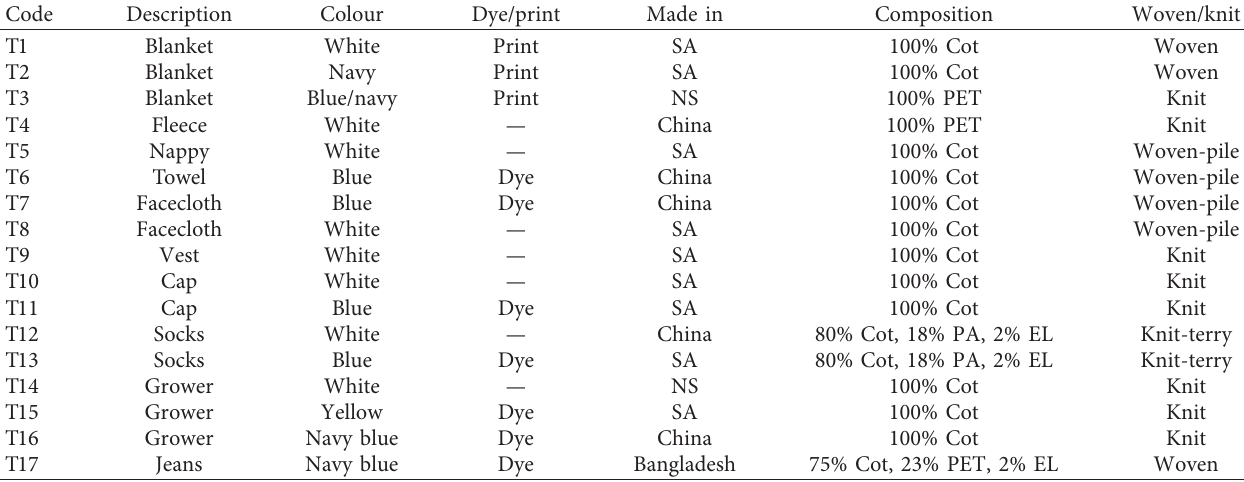
Table 1: Sample code, description, colour, composition, and apparel type from a high-end market store. Code